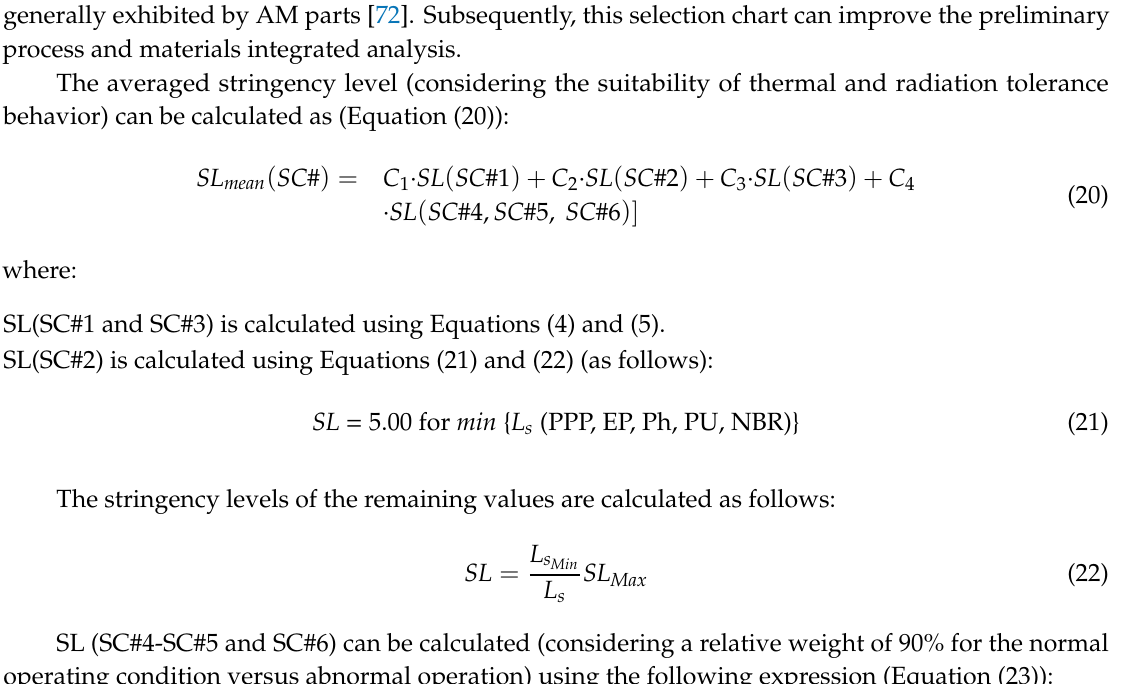
Figure 11. Material selection chart for nuclear applications.